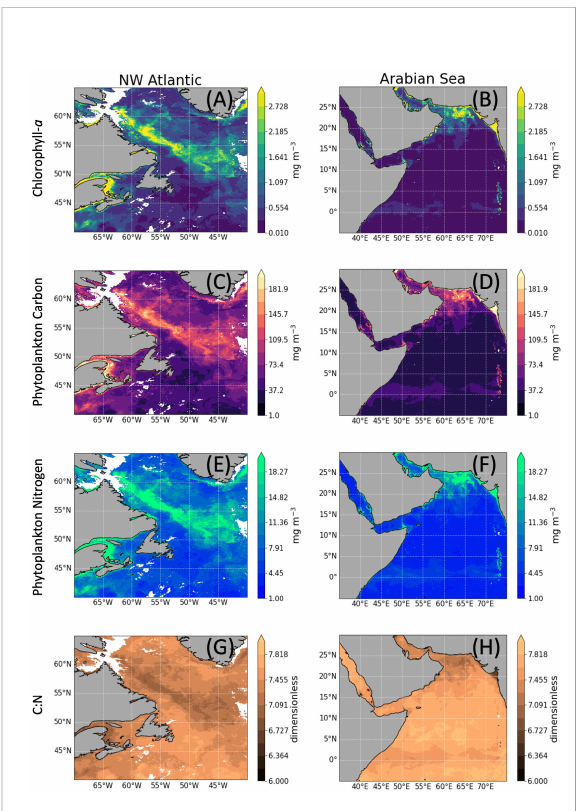
FIGURE 5 Satellite estimates of chlorophyll-a (A, B) , quantile regression-derived autotrophic carbon (C, D) and nitrogen (E, F) , and phytoplankton C: N ratio (G, H) . Maps were generated based on remotely sensed OC- CCI chlorophyll data for an 8 day relatively clear sky composite of the Northwest Atlantic [10-17/06/2006, left-hand side panels (A, C, E, G) ] and the Arabian Sea [22-29/03/2005, right-hand side panels (B, D, F, H) ] with a 4 km spatial